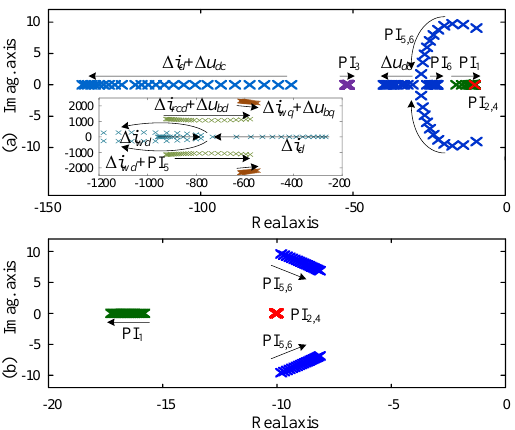
Figure 13. Root loci of the small-signal model. ( a ) k p 5 = 0.4 and k i 5 changes from 50 to 1000; ( b ) k i 5 = 50 and k p 5 changes from 0.1 to 2.0.